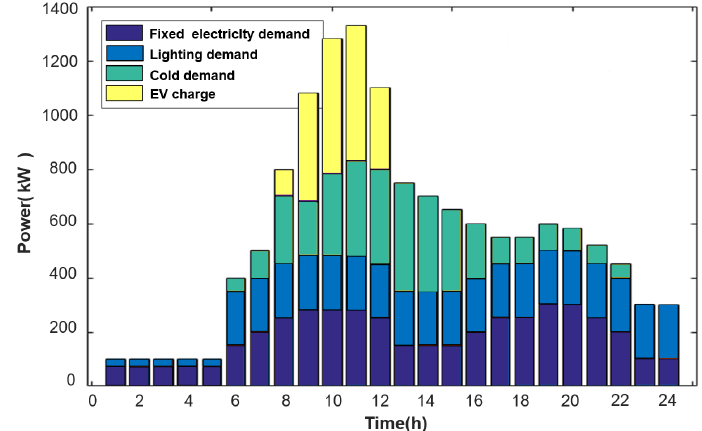
Figure 7. Power consumption in summer for commercial users.